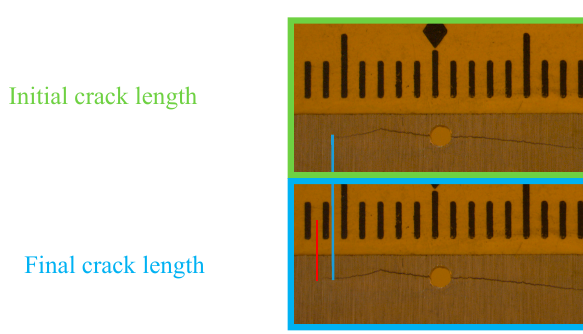
Figure 21. The initial tip-to-tip crack length was approximately 14 mm. After 2000 fatigue cycles, an advancement in the crack length of 2 mm was observed.